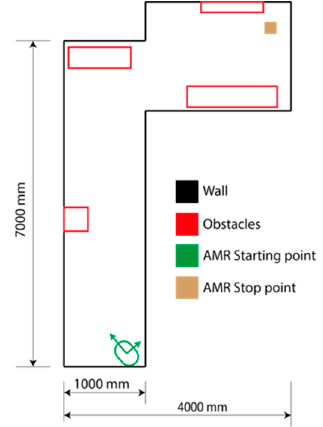
Figure 9. Sketch of the indoor scenario.